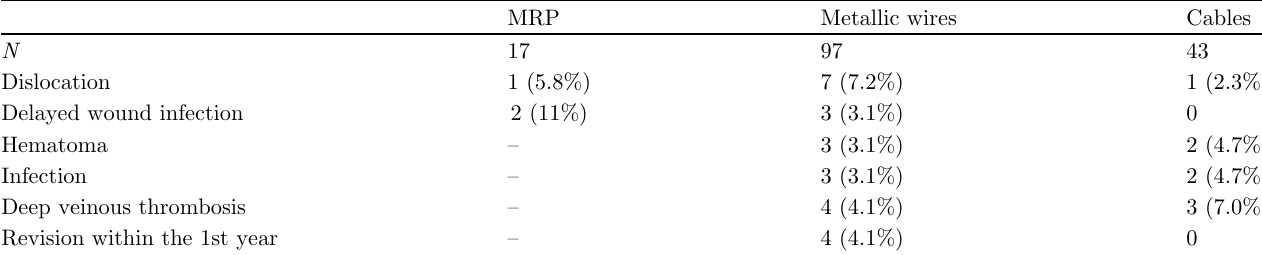
Table 4. Complications.